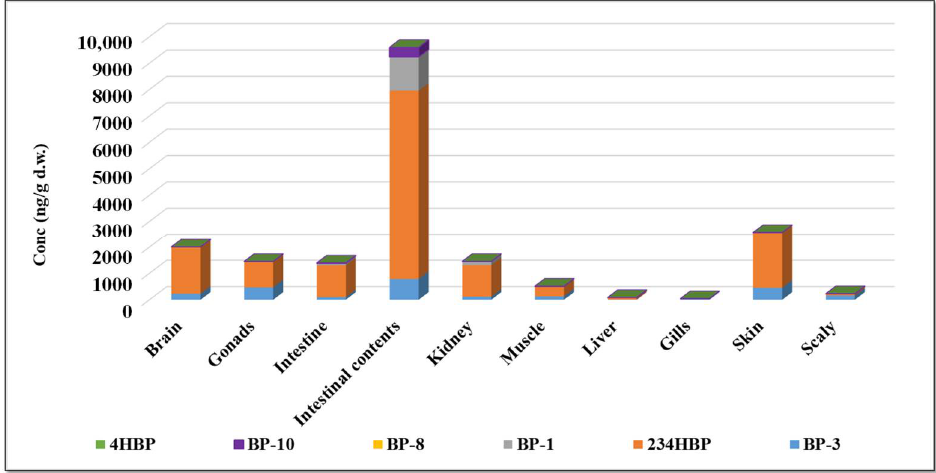
Figure 3. Distribution of BP-3 UV filter and its metabolites in fish organs.